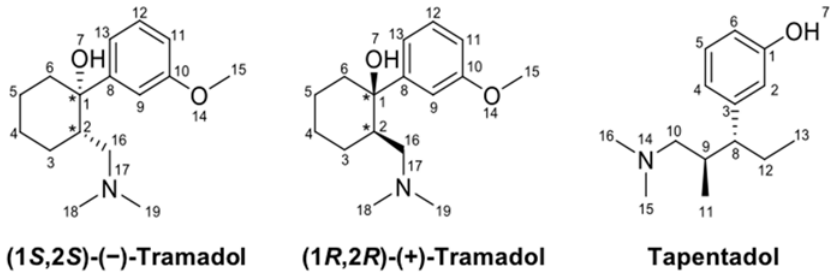
Figure 1. Chemical structures of tramadol and tapentadol. The chemical structures of tramadol (+)- and ( − )-enantiomers are depicted. The stereocenters are depicted with asterisks. Atom positions are sequentially numbered.